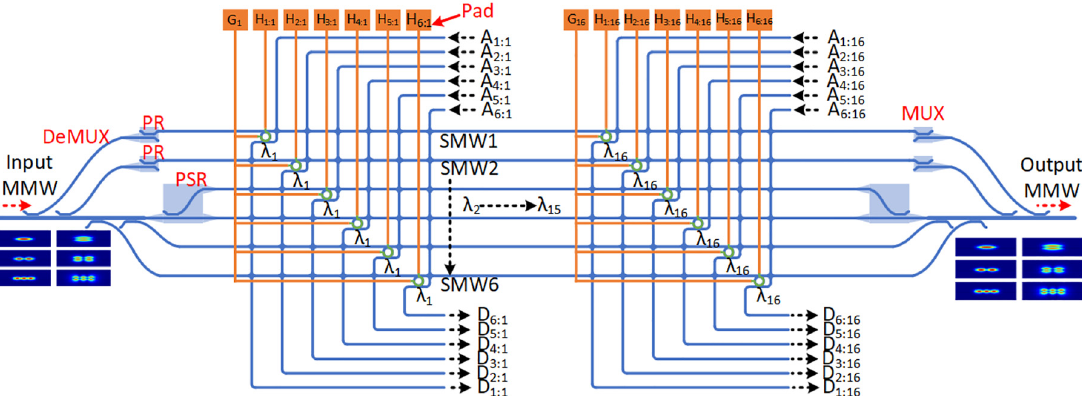
Figure 1: Configuration of the proposed ROADM for the hybrid MDM-PDM-WDM systems. switching the resonant wavelength of the corresponding MRR to/away from the target 𝜆 n . After passing through modes from the SMWs are the switches array, these six TE 0 thenmultiplexedintotheMBWbyanothermodeMUXcom- bined with PRs/PSRs. Similarly, when the n th wavelength- channel( 𝜆 n )isdroppedtoport D m − n ,onecanalsoaddlocal signalscarriedbywavelength 𝜆 n fromport A m tothesame : n